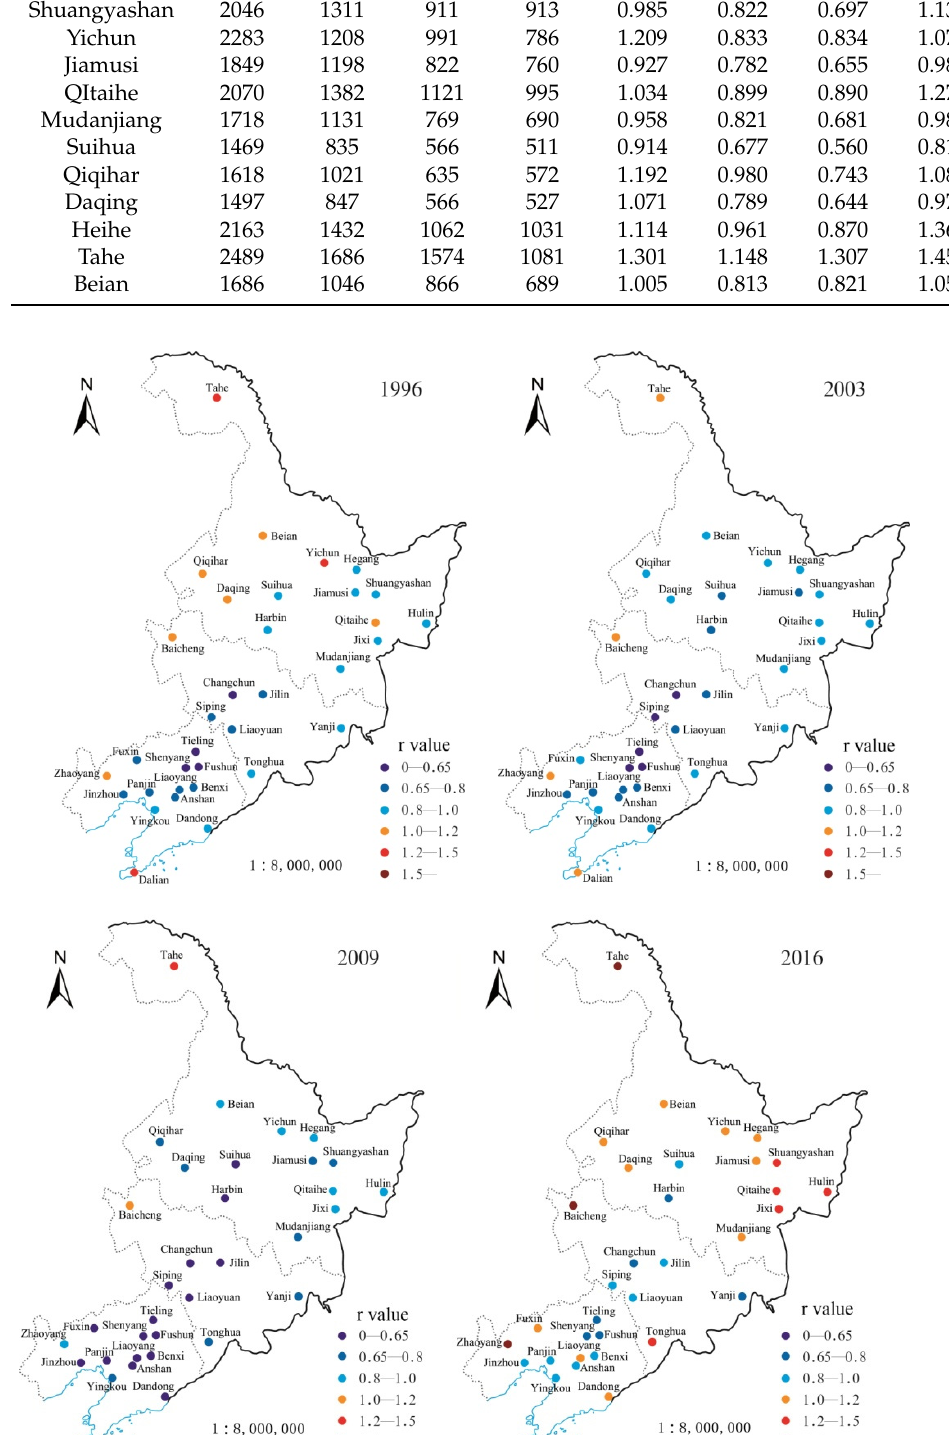
Figure 9. Changes in STCP for cities in northeast China from 1996 to 2016.